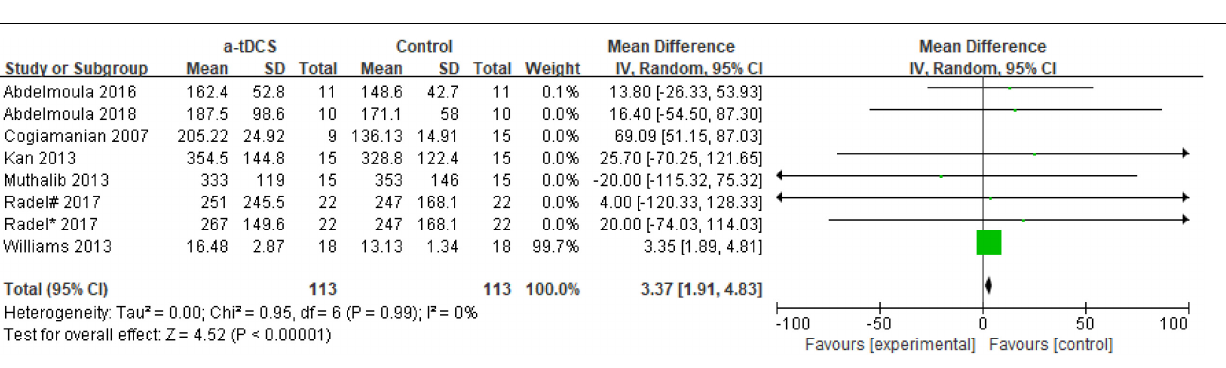
FIGURE 4 | Forest plot of a subgroup analysis of the effect of a-tDCS on enhancing upper limb muscle endurance. Radel#- Stimulate the prefrontal cortex; Radel*- Stimulate the primary motor cortex(M1).